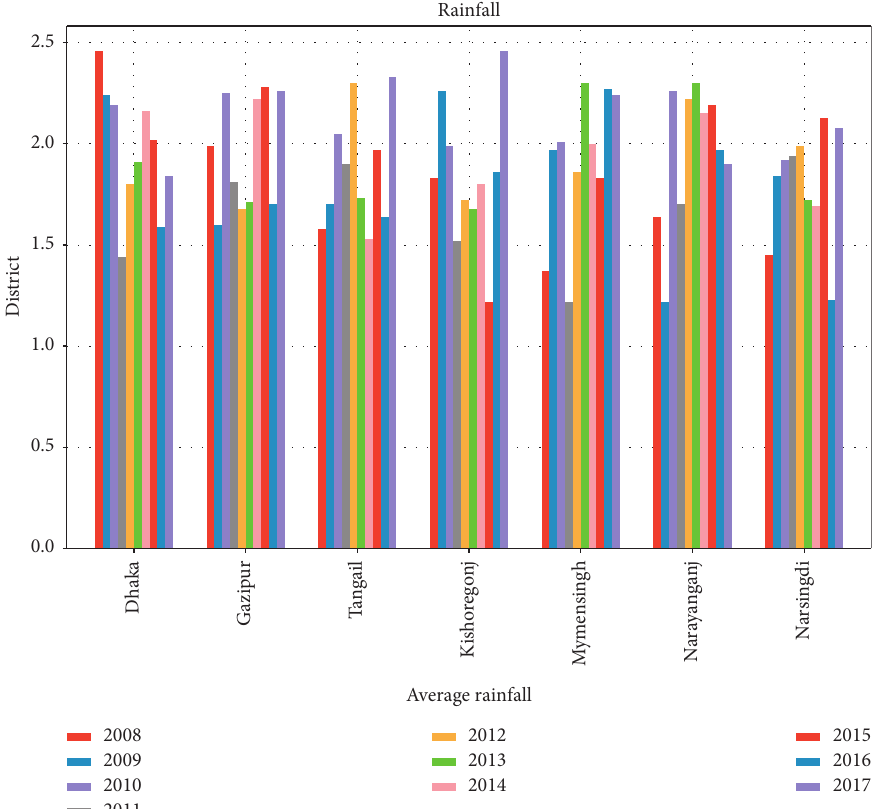
Figure 3: Analysis of average